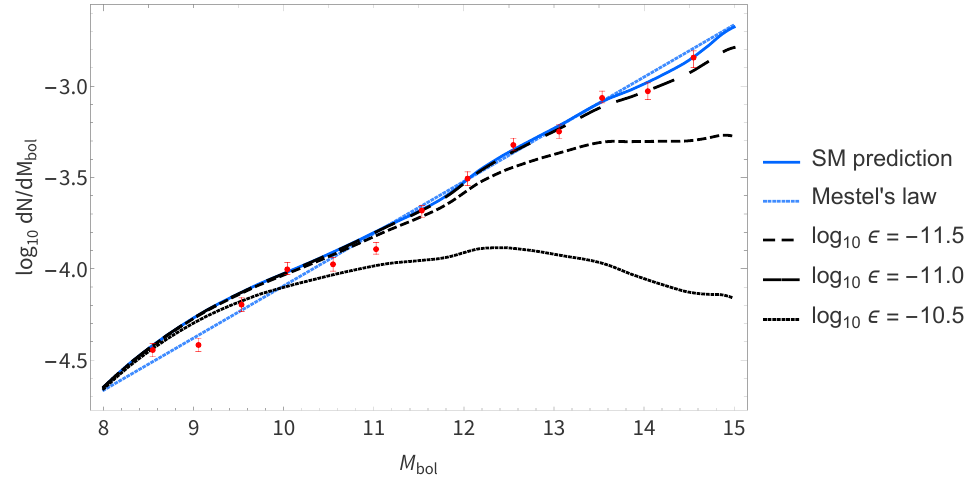
= { m forming ˜ p , m ˜ e } p , m e }